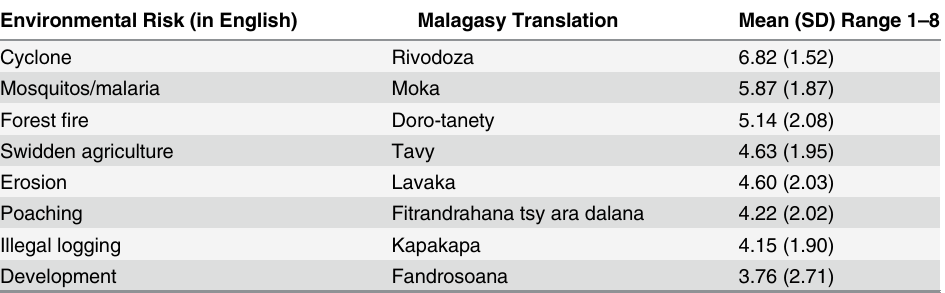
Table 1. Eight threats to environmental security in Torotorofotsy, Madagascar in May 2014 (n = 88). Environmental Risk (in